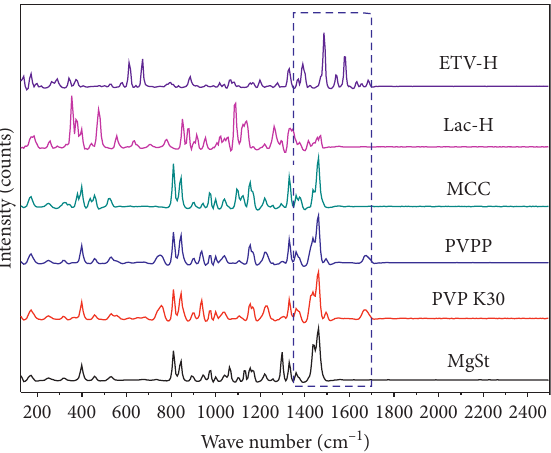
Figure 3: Raman spectra of raw ETV-H and all excipients used in Baraclude’s